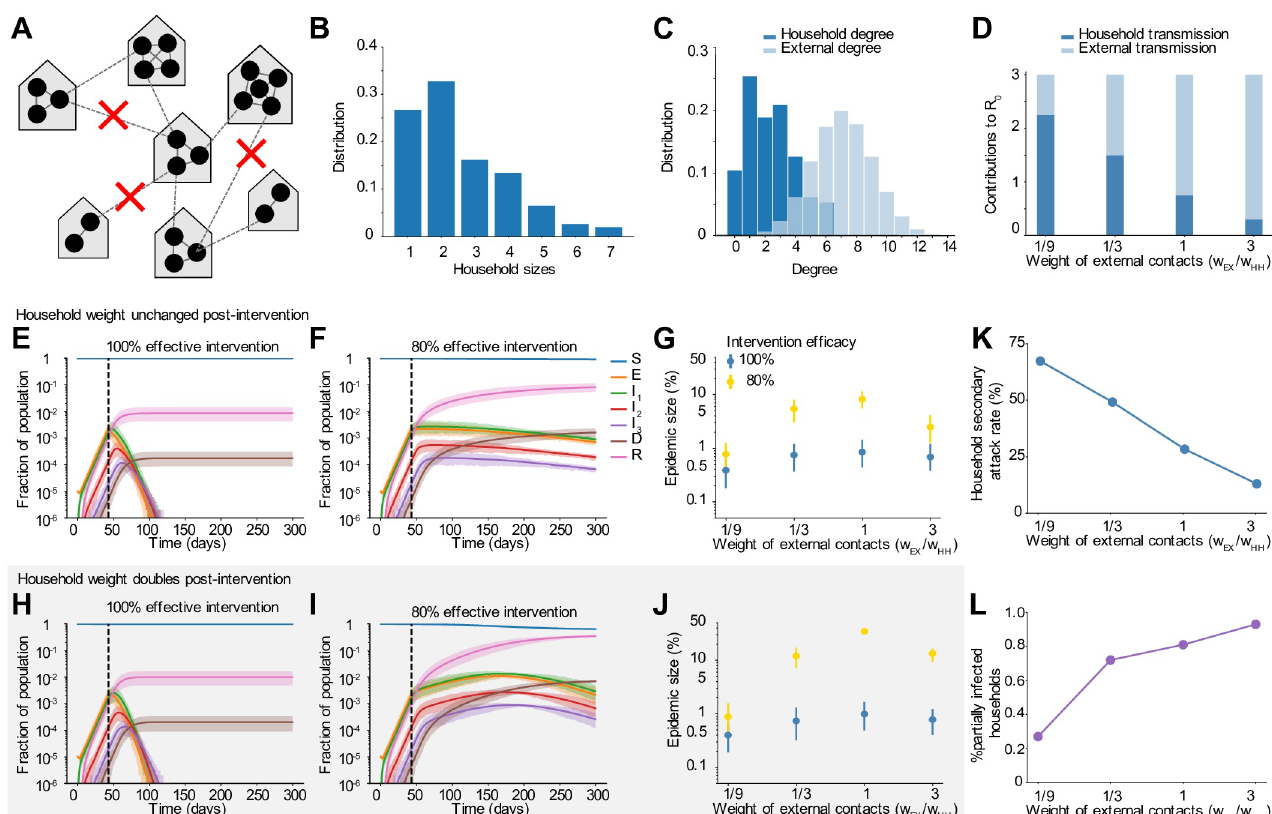
Fig 3. Dynamics pre and post social distancing interventions in network-structured populations with household and external transmission. A) Multi-layer network of transmission. Individuals have contacts within their households and with others outside the household. Household and external contacts may have different weights (e.g. different likelihood of transmission), due to for example different levels of physical contact or time spent together per day. Social distancing interventions (red X) remove or decrease the weight of external contacts. B) Distribution of household sizes. C) Distribution of the # of contacts (degree) within the household and outside the household. D) The contribution of household and external spread to the total R 0 value as a function of the relative weight of external contacts. E)-F) Simulated time course of different clinical stages of infection under an intervention with efficacy of 100% (E) or 80% (F) at reducing external contacts, when household and external contacts have equal weight. Black dotted line shows the time the intervention began. G) The role of the relative importance of household vs external contacts in determining the outcome of the intervention, measured by the size of the epidemic. Epidemic final size is defined as the percent of the population who have recovered by day 300. H-J) Same as above but under the scenario where the weight of household contacts doubles post-intervention ( w ! 2 w , due to increased time spent in house). K) The household secondary attack rate, defined as the probability of HH HH transmission per susceptible household member when there is a single infected individual in the house, as a function of the relative weight of external contacts. L) The percent of households which are “seeded” with infection at the time the intervention was implemented (i.e. have at least one infected individual). In all scenarios the overall infection prevalence at the time intervention was started was